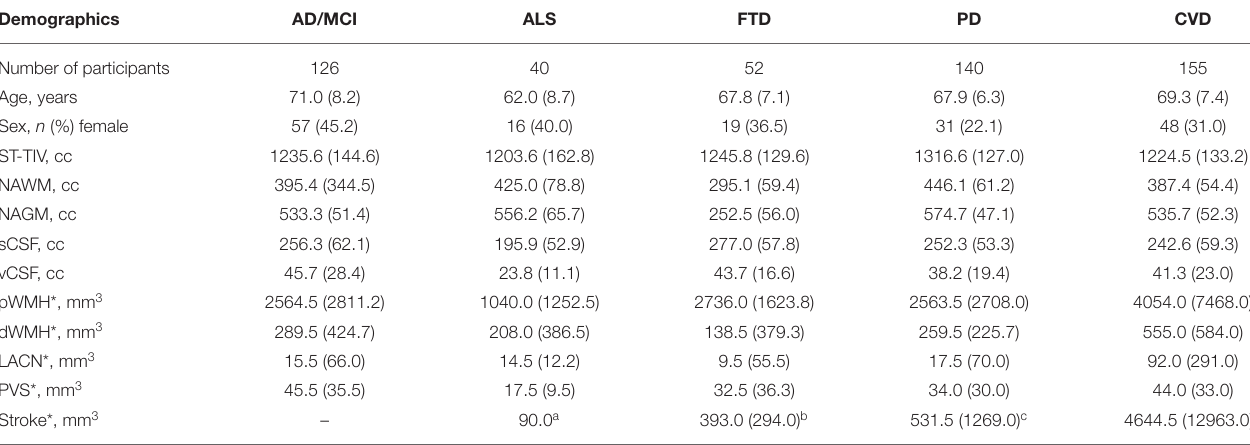
TABLE 2 | Data is shown as mean (standard deviation) unless otherwise specified. Raw values are presented for transparency purposes.